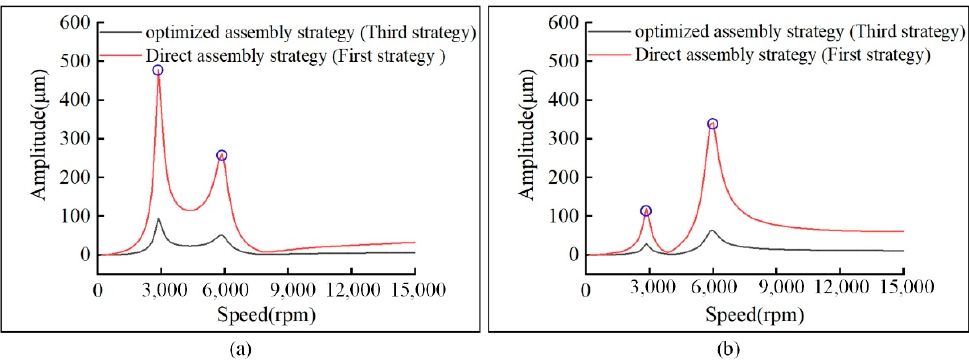
Figure 5. Vibration amplitude under different assembly strategy: ( a ) Vibration amplitude of drive end; ( b ) Vibration amplitude of non-drive